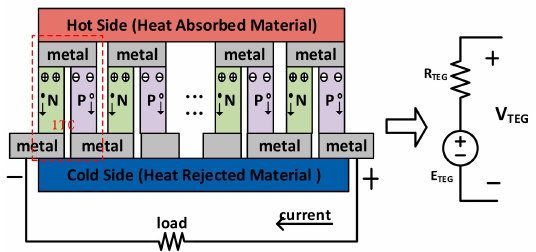
Figure 1. Thermoelectric generator and its equivalent electrical model.